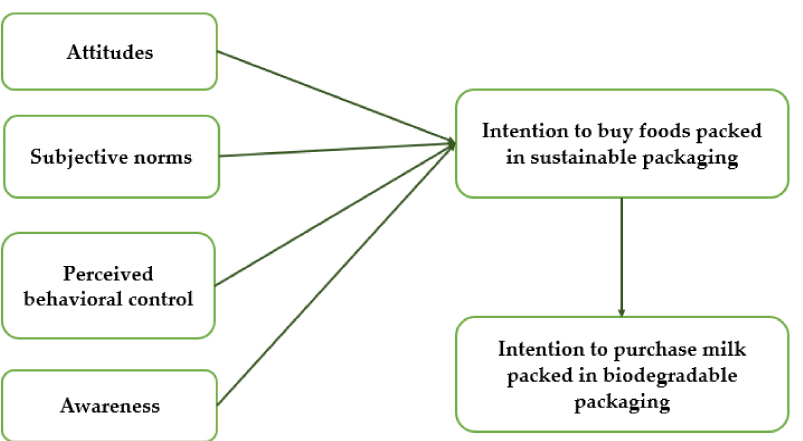
Figure 1. Determinants of the consumer’s intention to buy foods packed in sustainable packaging and intention to purchase milk packed in biodegradable